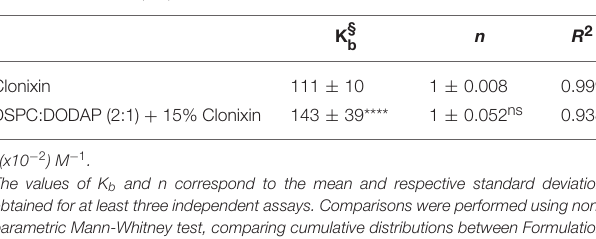
TABLE 4 | Binding constant (K b ) and number of binding locations (n) of Clonixin and DSPC:DODAP (2:1) loaded with 15% of Clonixin to